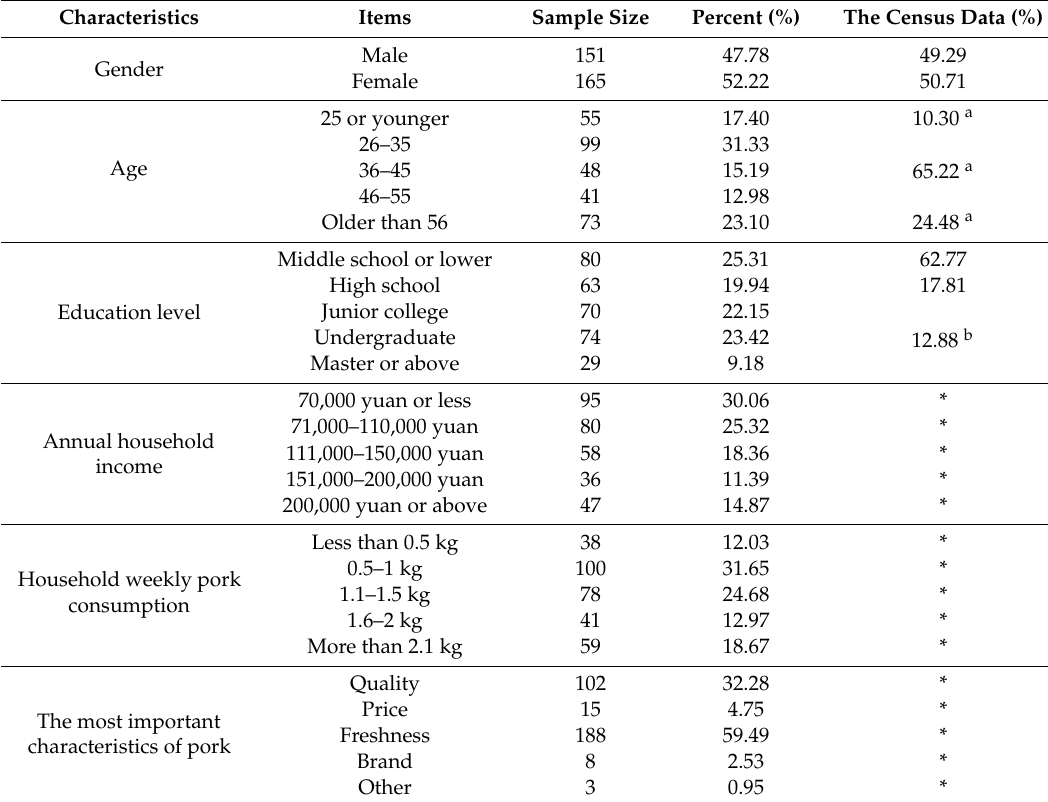
Table 2. Respondents’ individual